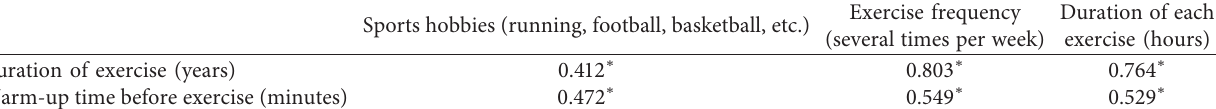
Table 7: Pearson